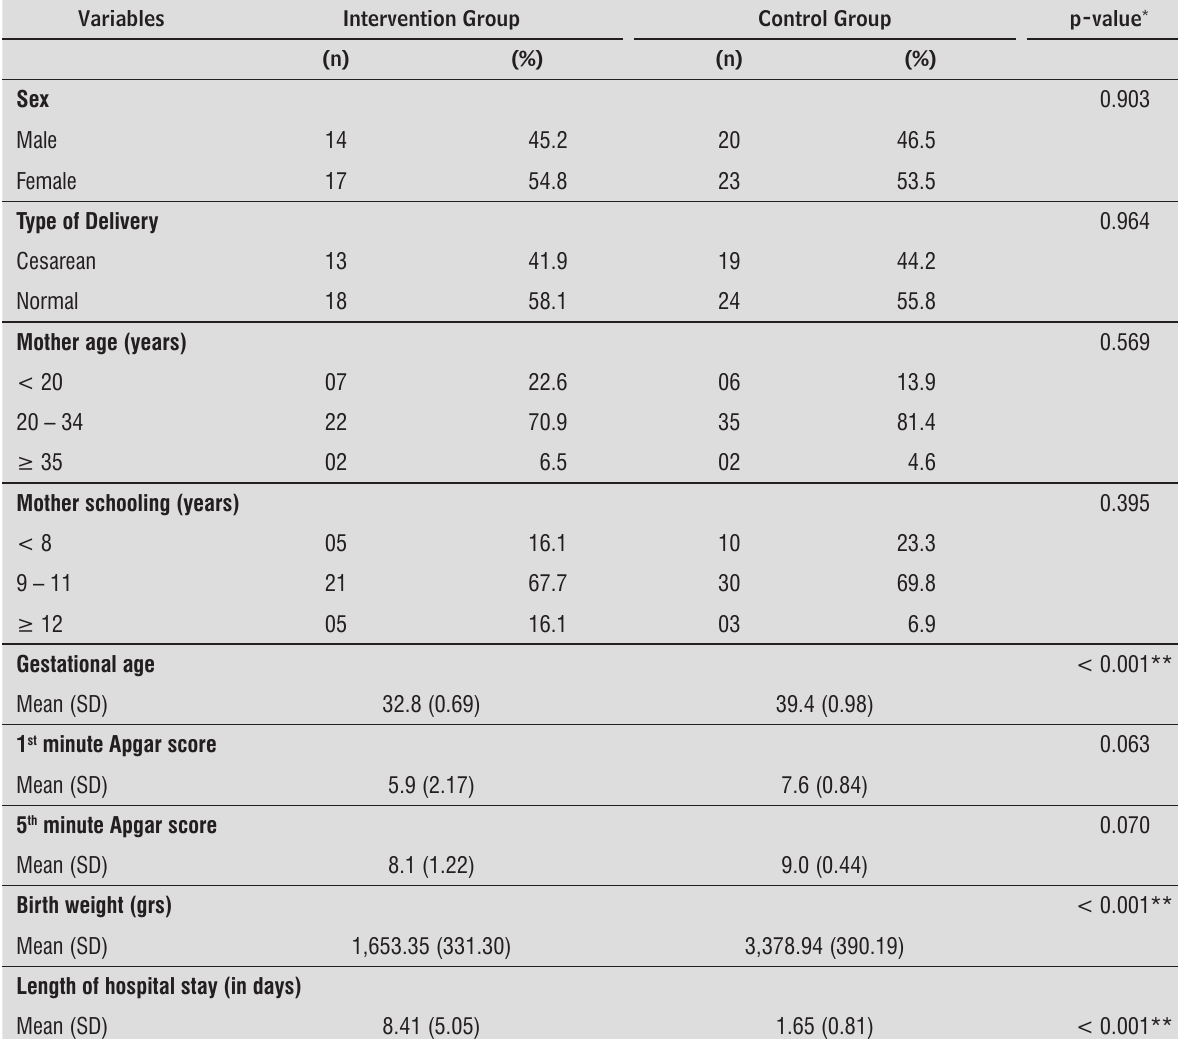
Table 1 - Characteristics of newborns allocated to evaluating the neuromotor development; Montes Claros (MG), 2009-